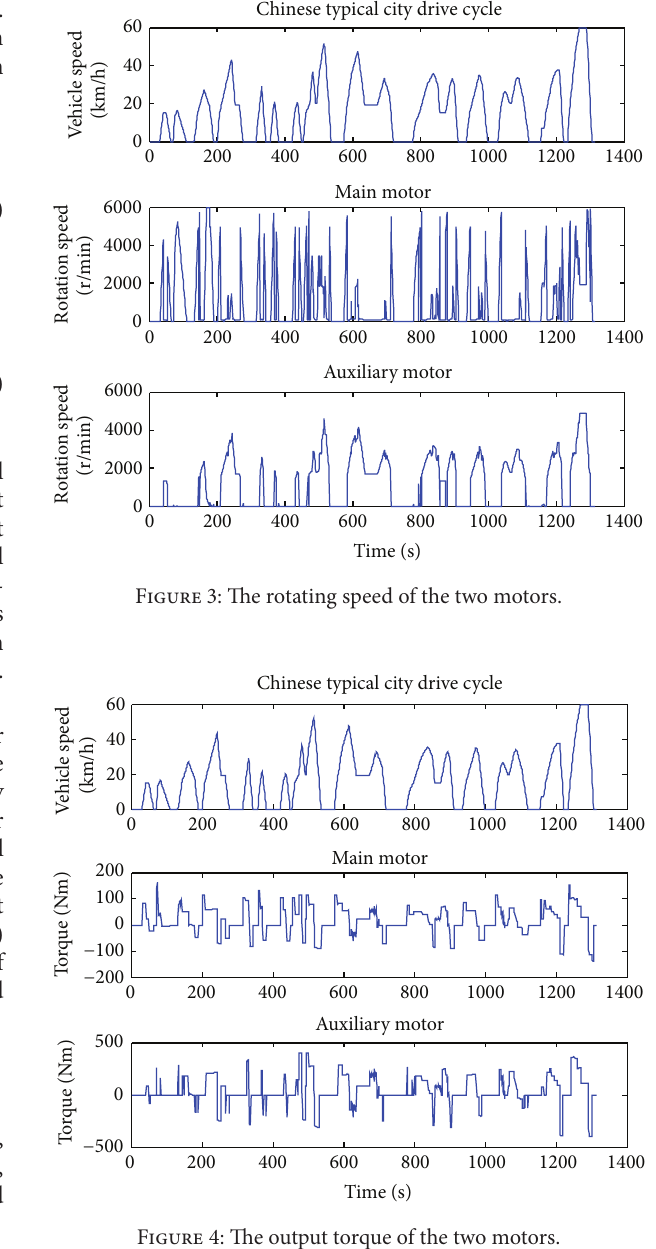
Figure 4: The output torque of the two